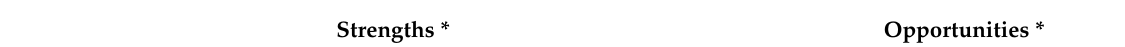
Table 2. Summary comparative table on the ankle injury rehabilitation robot (AIRR)’s features with the strengths and